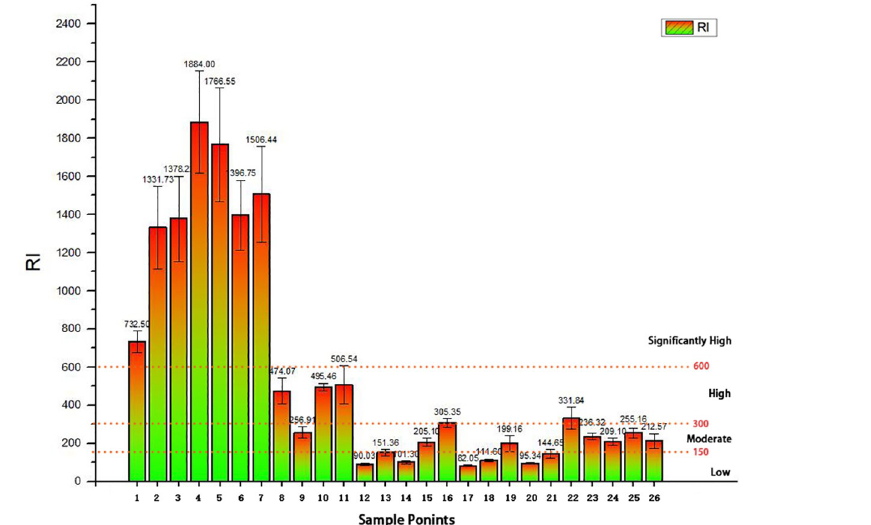
Fig 4. RI and comprehensive PER of each sample